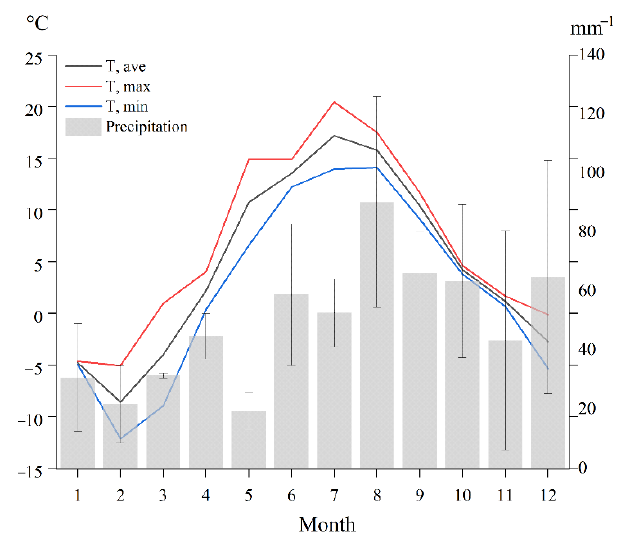
Figure 3. Climatic data (temperature and precipitation) from exposure site in 2017–2019.